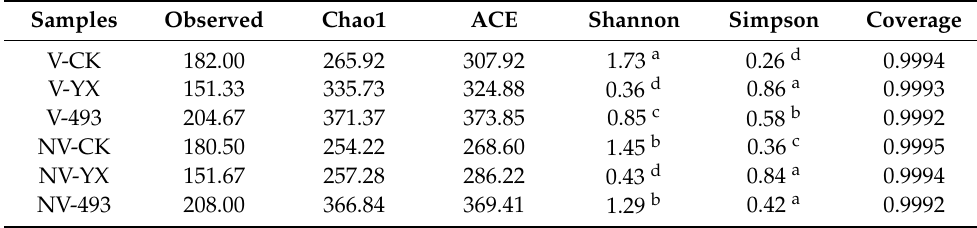
Table 3. Alpha diversity of bacterial diversity at 90 days of